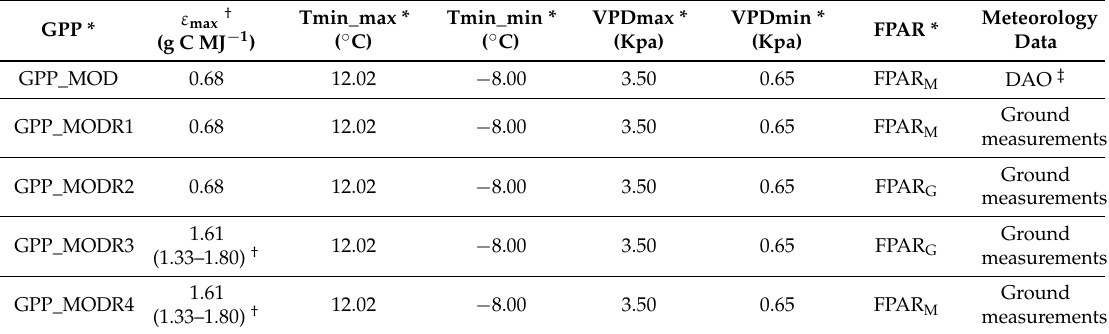
* GPP list represents the diverse GPP values from different models based on the MOD17A2 algorithm according to data source showed in this table; * Tmin_max, Tmin_min, VPDmax, and VPDmin are the upper limit, the lower of daily minimum temperature, the upper, and the lower of daily minimum vapor pressure difference, respectively. All of them are extracted from the Biome Properties Look-Up Table (BPLUT) in grassland